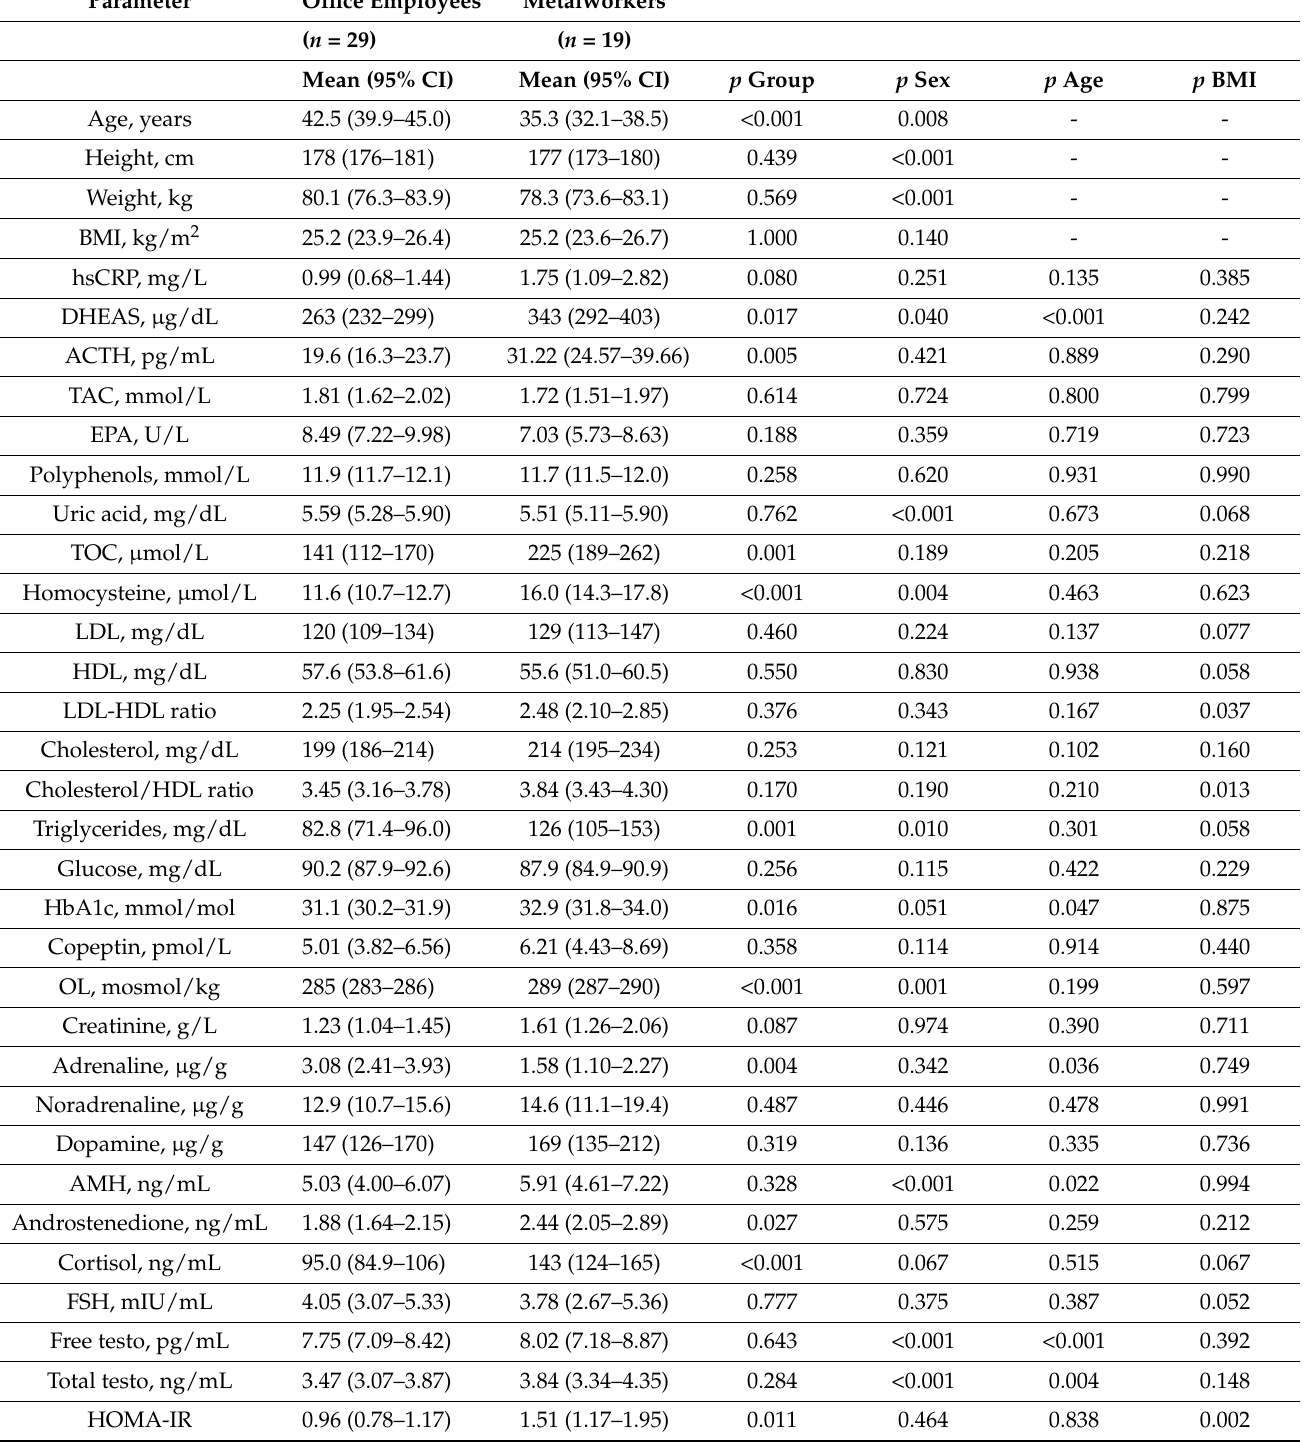
Table 1. Baseline characteristics of different parameters in office employees and